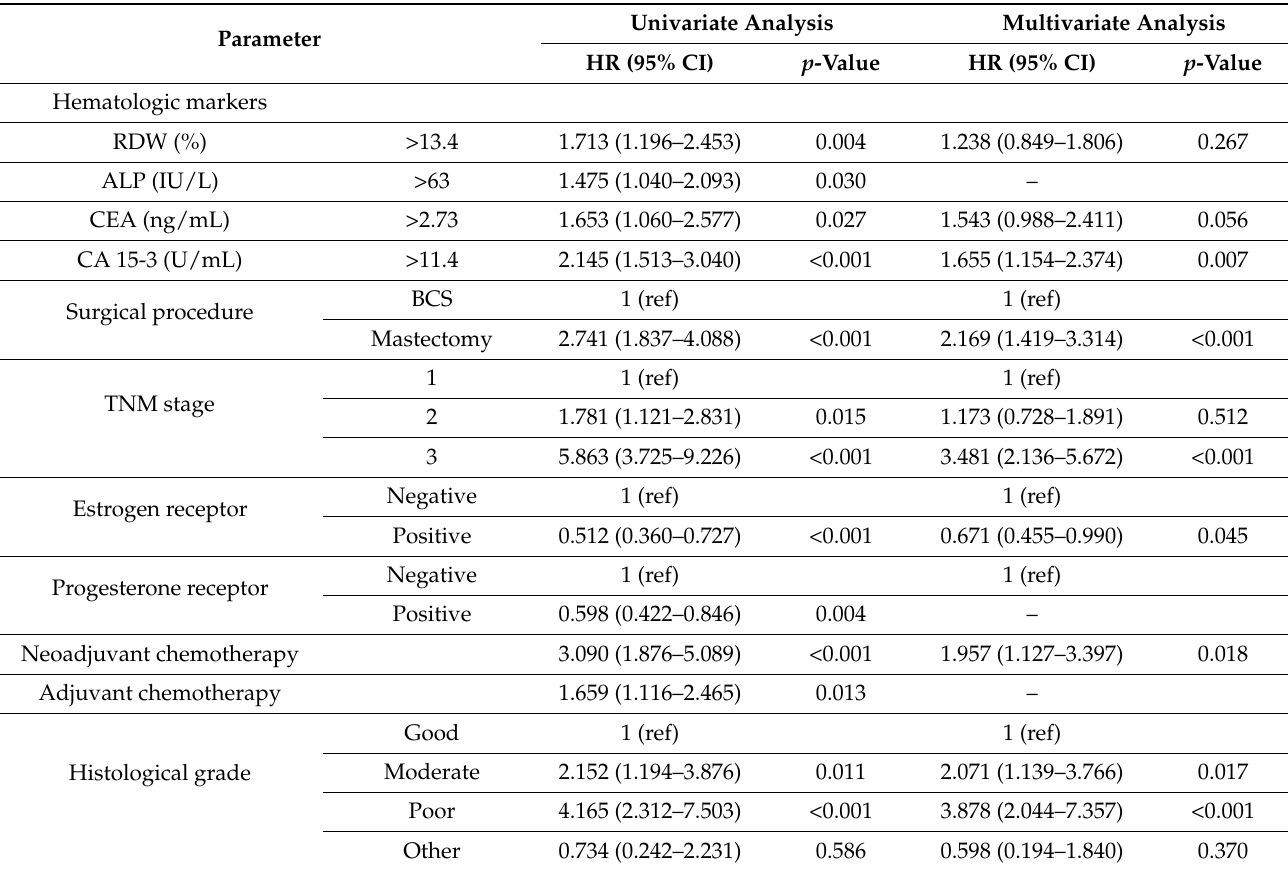
Table 3. Independent risk factors for patients with breast cancer associated with postoperative recurrence after Cox regression analysis with 1 to 5 propensity score